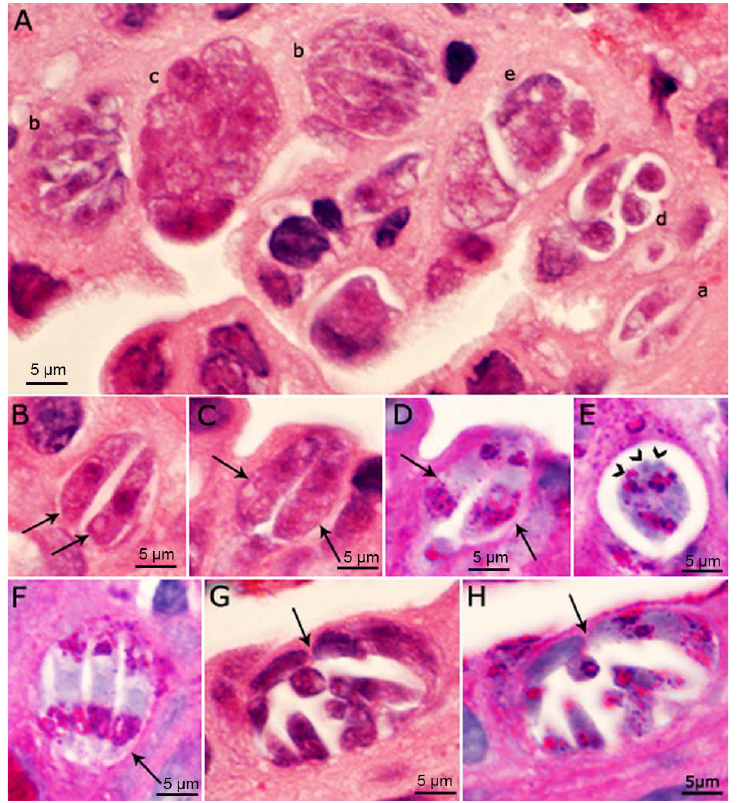
Figure 3. Asexual stages of Cystoisospora belli in histological sections of bile duct of a patient. Bar applies to all parts. ( A – C , G ) = Hematoxylin and eosin stain; ( D – F , H ) = PAS counter stained with hematoxylin. The luminal side of sections is on the top. ( A ) Several meronts in one microscopic field. (a) Paired merozoites in one pv. (b) Meront with four or more merozoites completely filling the pv. (c) Meront containing developing merozoites. The organisms are cut in cross-section; the nuclei appear larger than in merozoites. (d) Four merozoites in a pv with spaces between merozoites. (e) Immature meront. ( B ) Paired crescent-shaped merozoites. ( C , D ) The same paired organisms/meronts after staining with HE ( C ) and PAS ( D ). Note the polar PAS-positivity. The parasite nuclei are masked by PAS staining. ( E ) Meront with mero- zoites budding (arrowheads). Note PAS-positivity. ( F ) Meront (arrow) with three merozoites with polar PAS-positivity. ( G , H ) The same mature meront (arrow) after staining with HE ( G ) and PASH ( H )